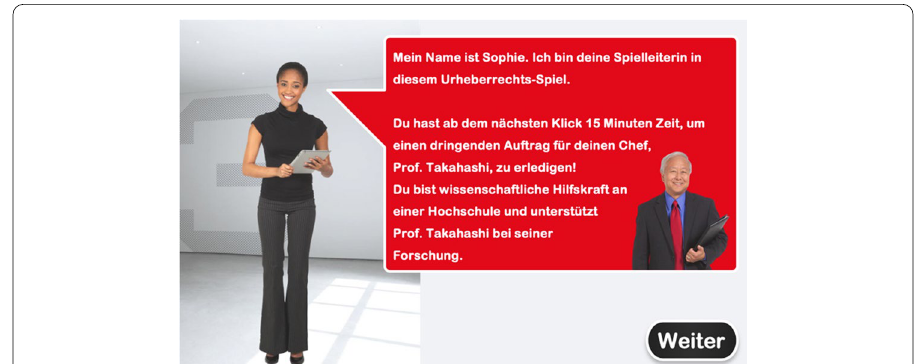
Fig. 2 Female and male avatar that support the storyline and the player during the game